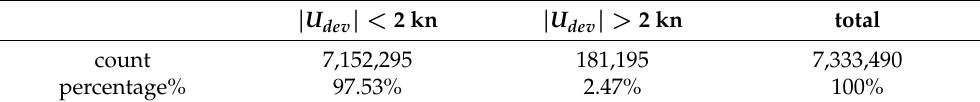
Figure 7. KDE plot on top of correlation scatterplot of U GPS versus U DVL from 190 container ships. Checking on the percentage of points distributed among the 2 kn boundary, on Table 9 one can see that only 2.47% out of ≈ 7 million points are considered to be either DVL or GPS failure. Even small fractions of DVL failure can contribute to huge costs, especially for companies operating hundreds of ships. Table 9. Speed deviation U dev above and below 2 kn